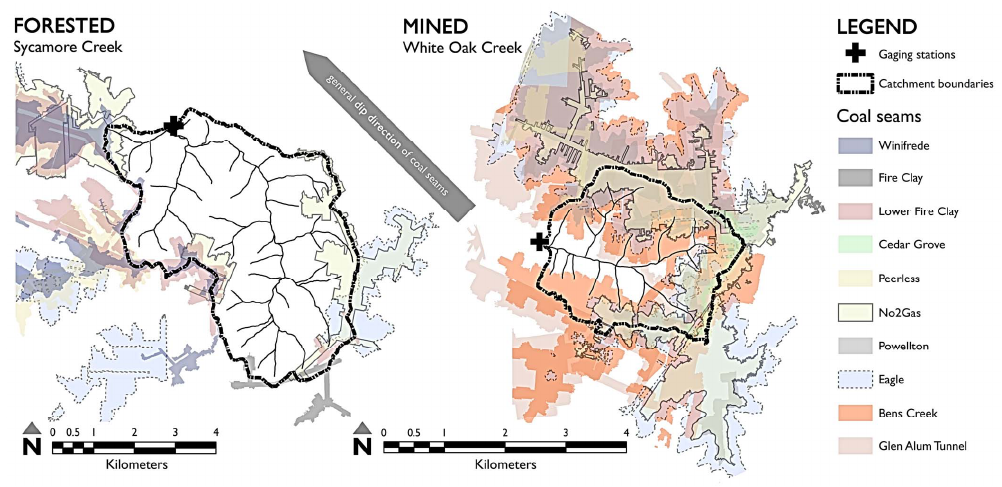
Figure 3. Underground mines below the mountaintop mined White Oak Creek and the forested Sycamore Creek catchments. Coal seams are listed in stratigraphic order, and the dip direction is northwest. Mean dip in the mined catchment is 0.92 ◦ and 0.74 ◦ in the forested catchment. Approximately 85% of the mined catchment area and 20% of the forested catchment area are directly underlain by underground mines. When including up-dip underground mine areas, the contributing drainage area increases over the topographically-delineated area by ∼ 240% in the mined catchment and by > 80% in the forested